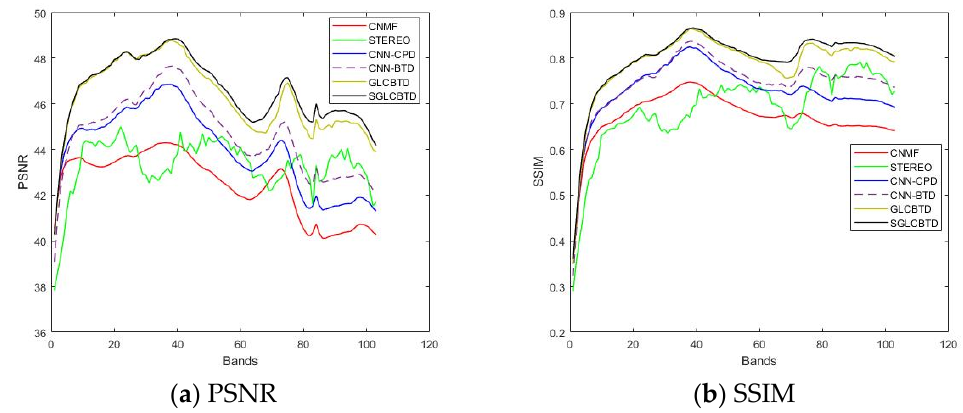
Figure 6. PSNR and SSIM in function of each band for different methods on the Indian Pines da- taset.